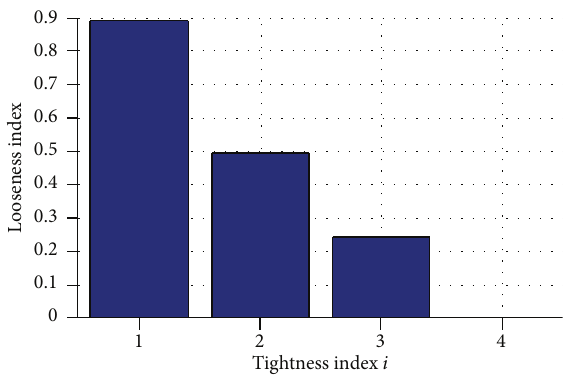
Figure10:Loosenessindex(PZT6asactuatorandPZT4assensor).